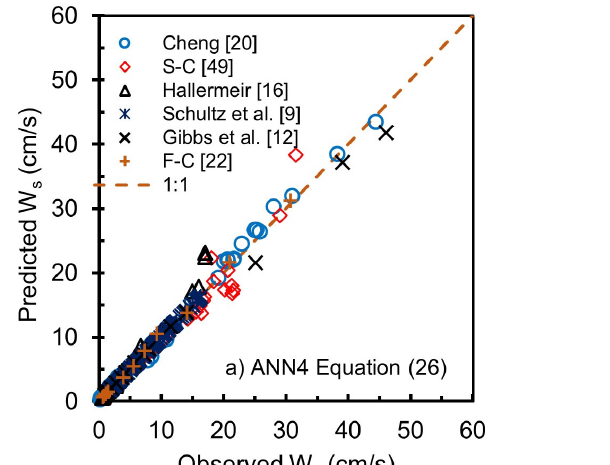
Figure 9. Scattering plot for results of testing 2 for equations of ANN5 ( a ); Jiménez and Madsen [21]